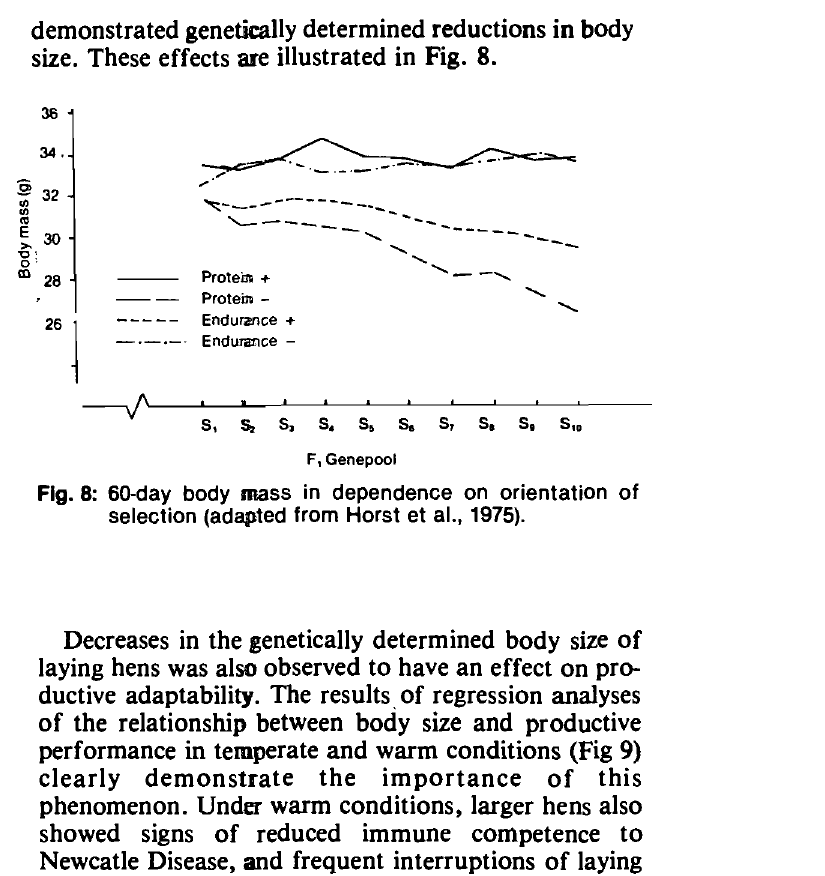
Decreases in the genetically determined body size of laying hens was also observed to have an effect on pro ductive adaptability. The results of regression analyses of the relationship between bociy size and productive performance in temperate and warm conditions (Fig 9) clearly demonstrate the importance of this phenomenon. Under warm conditions, larger hens also showed signs of reduced immune competence to Newcatle Disease, and frequent interruptions of laying were recorded.